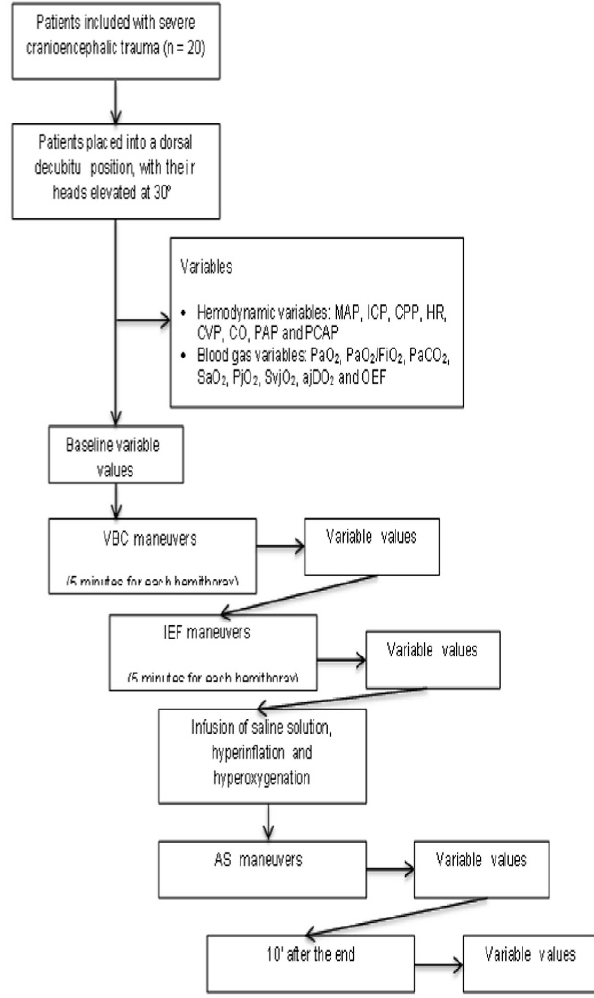
Figure 1 - Design and flow of participants through the clinical